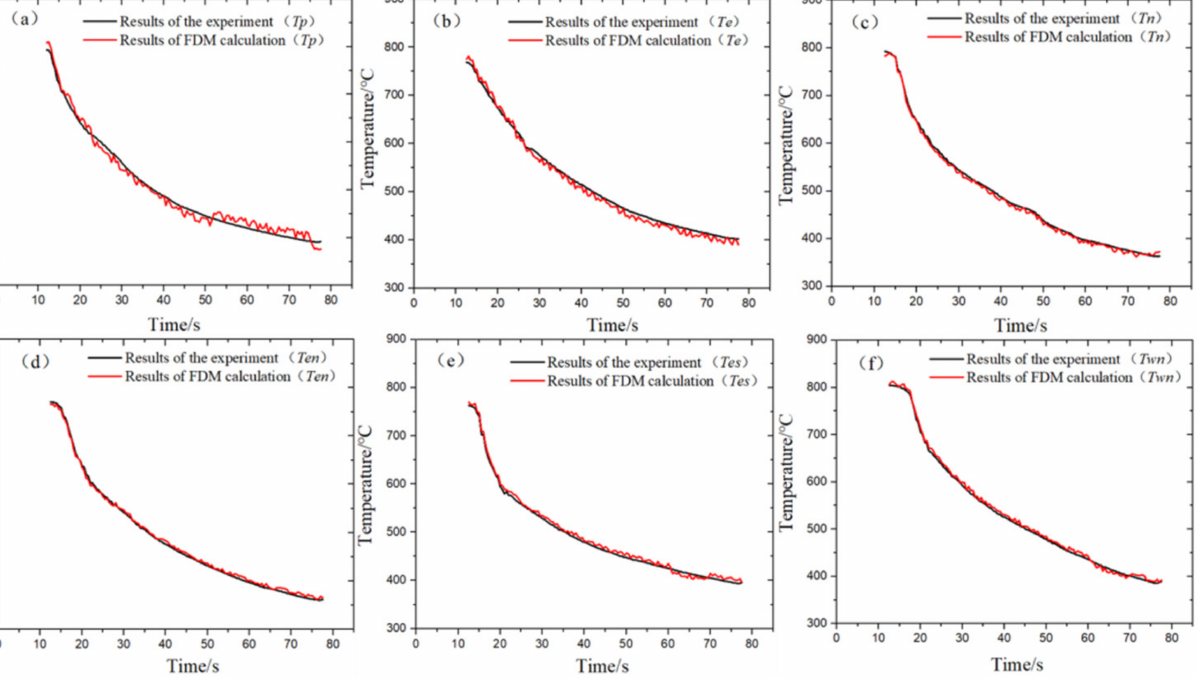
Figure 12. FDM calculated temperature and experimental temperature comparison. ( a ) Tp position experiment and simulation comparison, ( b ) Te position experiment and simulation comparison, ( c ) Tn position experiment and simulation comparison, ( d ) Ten position experiment and simulation comparison, ( e ) Tes position experiment and simulation comparison, ( f ) Twn position experiment and simulation